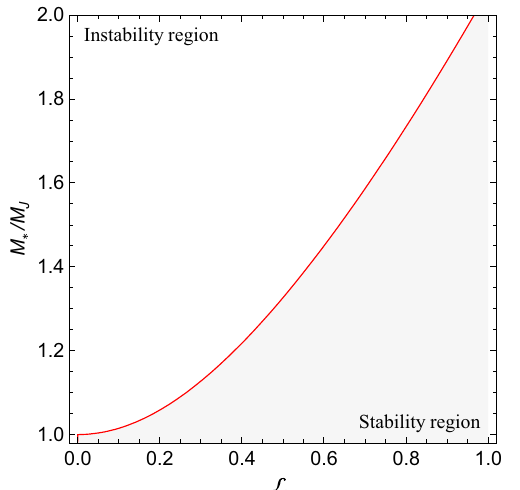
Figure 3. The dimensionless critical mass (48) versus the dimensionless characteristic length L